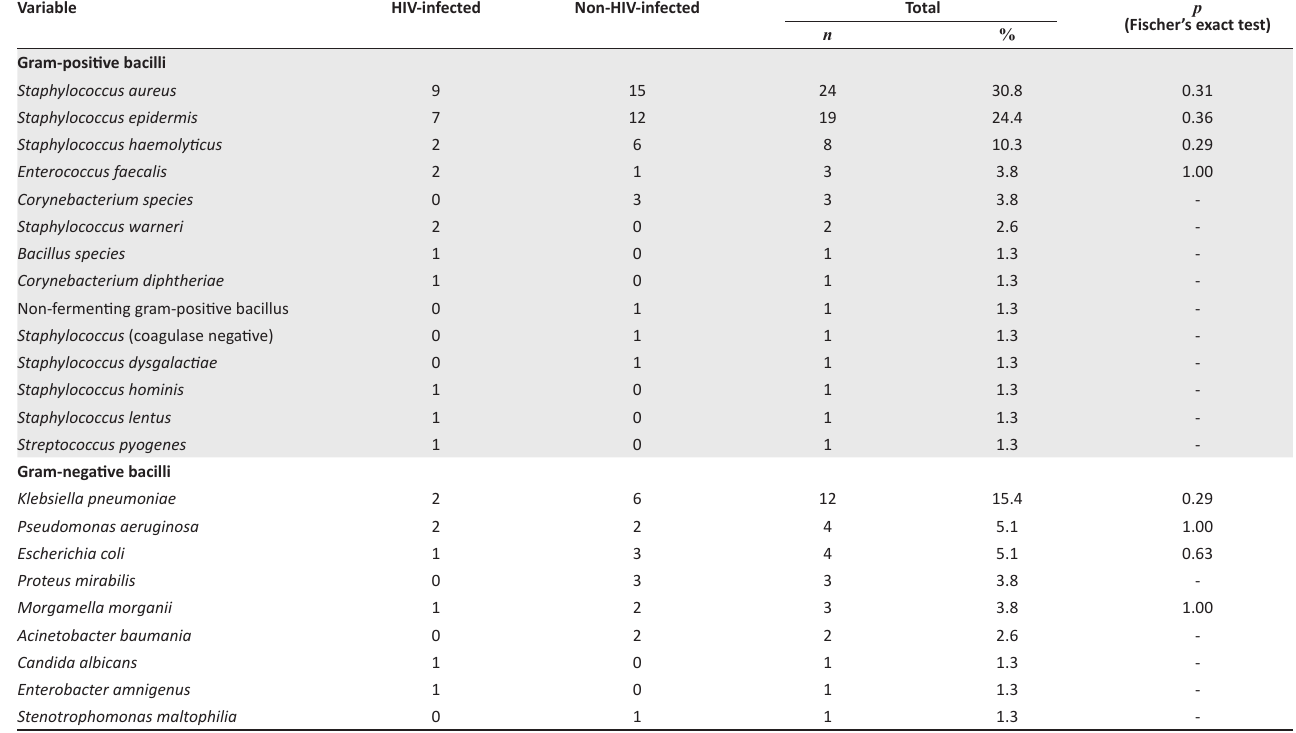
TABLE 4: The prevalence and antibiotic sensitivity of isolated microorganisms.